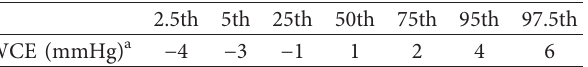
Table 1: Distribution of